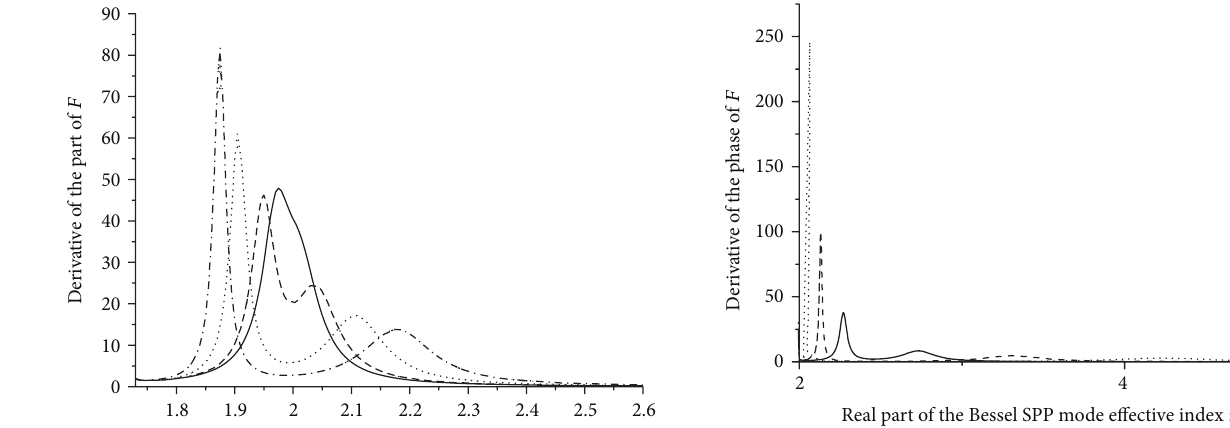
Figure 5: The derivative of the phase of 𝐹 function versus the real part of Bessel surface plasmon polariton mode effective index for gold film of 100nm ( — ), 80nm (- - -), 60nm ( ⋅⋅⋅ ), and 50nm ( ⋅ - ⋅ - ⋅ -) embedded in SF10 glass.